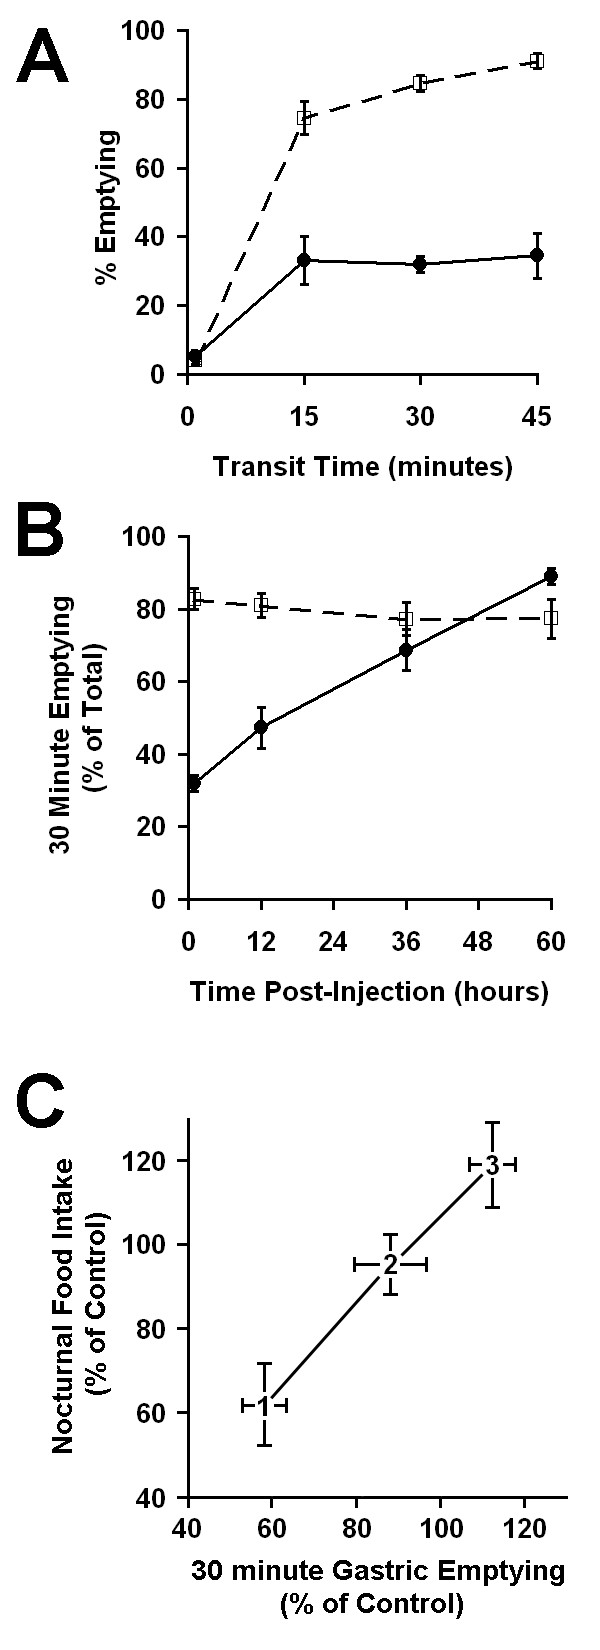
Effect of endotoxin on gastric emptying. A. Gastric emptying curve generated 1 hour after endotoxin (0.1 mg/kg, solid line) or carrier (dashed line) injection. A methylcellulose/phenol red dye meal was administered to different groups of mice by intragastric gavage. The amount of dye remaining in the stomach after a 1, 15, 30 or 45 minute transit period was measured. The percent of dye emptied was calculated relative to the total amount of dye gavaged. Each data point represents measurements from 3 – 7 mice. B. The recovery of gastric function was monitored by measuring the 30 minute emptying at various times after administration of endotoxin (0.1 mg/kg, solid line) or carrier (dashed line). N = 3–12 mice per group. C. Correlation plot comparing the recovery of food intake and gastric emptying. Data points represent percentages of the corresponding control. The data point numbers represent the first, second and third scotophase for food intake measurements (ordinate) or the gastric emptying measurement made preceding each scotophase (abscissa). Values are mean ± SEM.